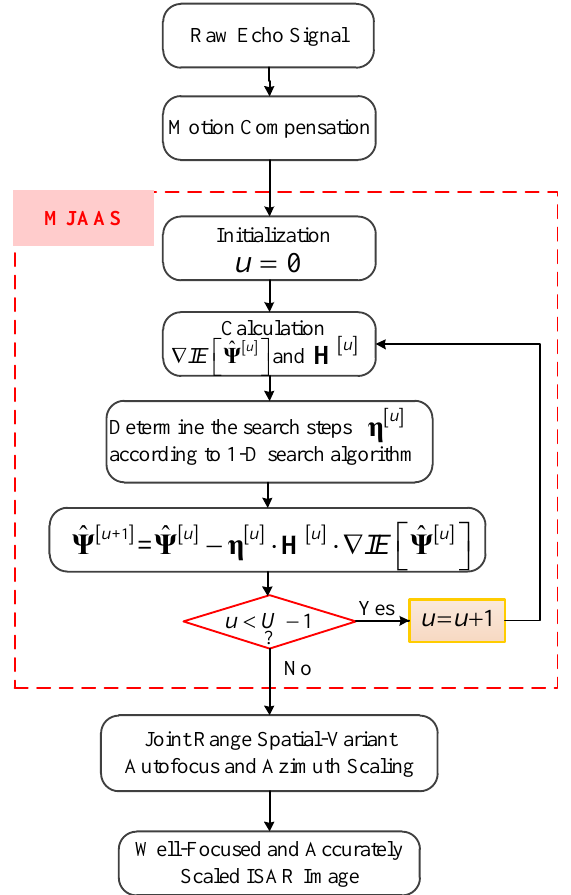
Figure 2. Flowchart of the proposed